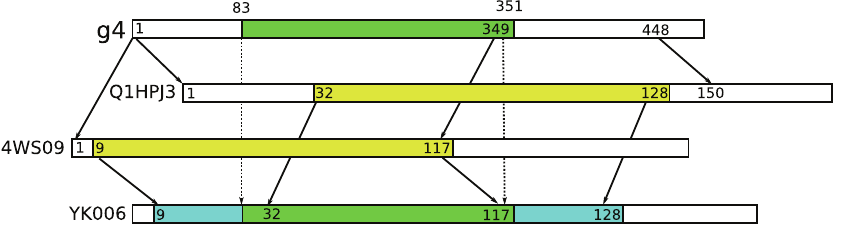
Figure 8. Using BLASTX to align the transcript (g4) to SwissProt identifies a short match (green) against YK006. BLASTX searches against UniRef 50 produces alignments (yellow) to proteins Q1HPJ3 and F4WS09. Both of these also match YK006, and these are used to construct the transitive alignment (blue) that covers almost the complete transcript. (For simplicity, other intermediate hits in UniRef 50 are omitted).